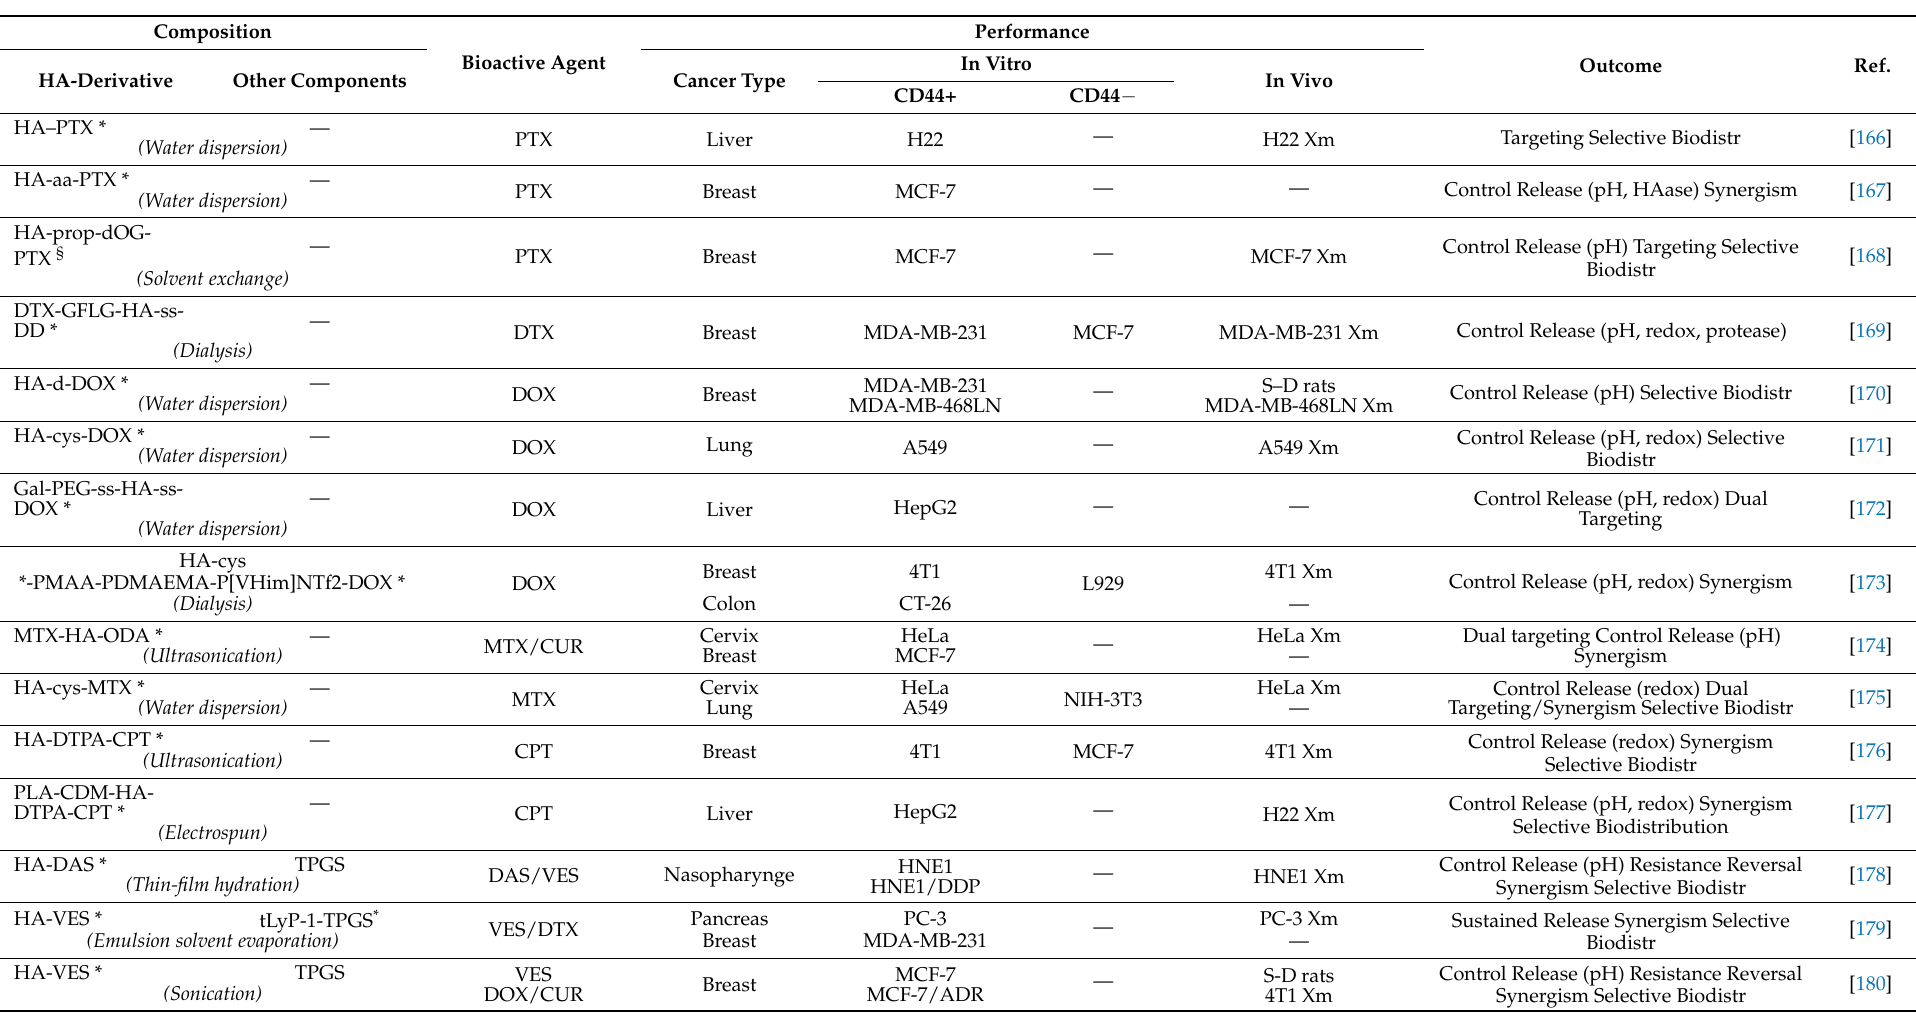
Table 7. HA-prodrug